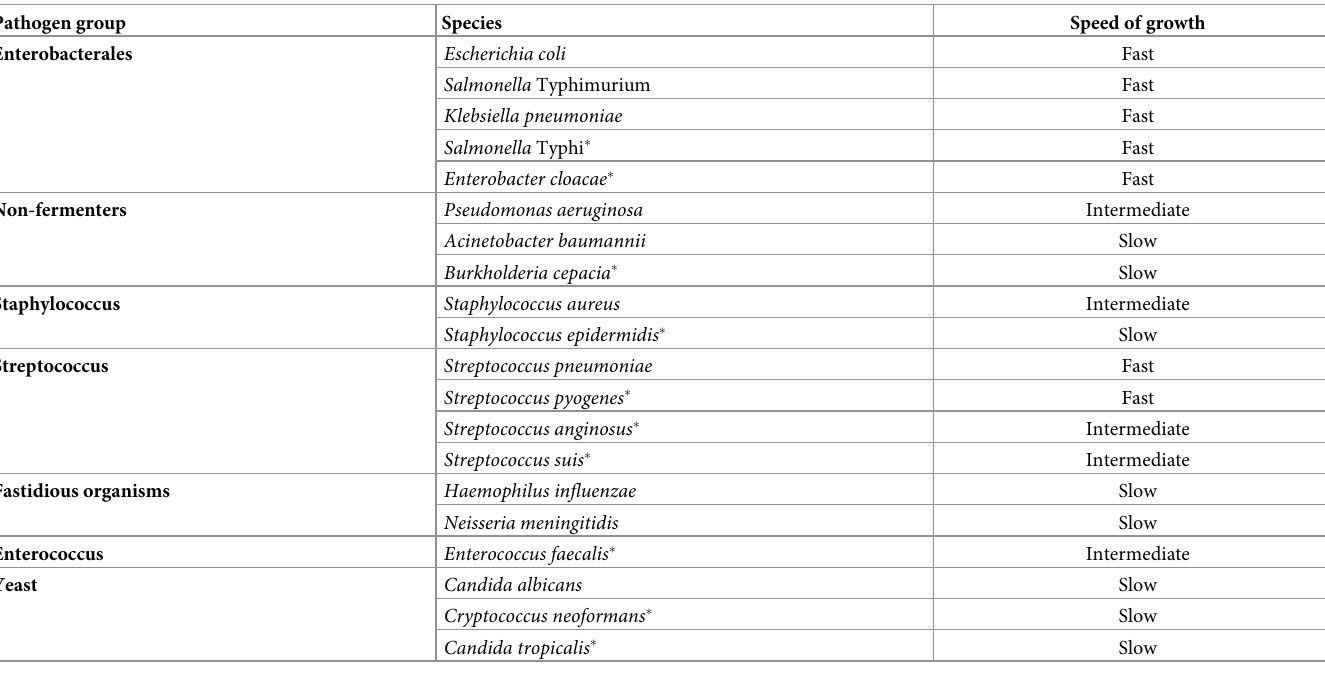
Table 4. Proposal for species to be tested in a blood culture bottle performance validation study in low-resource